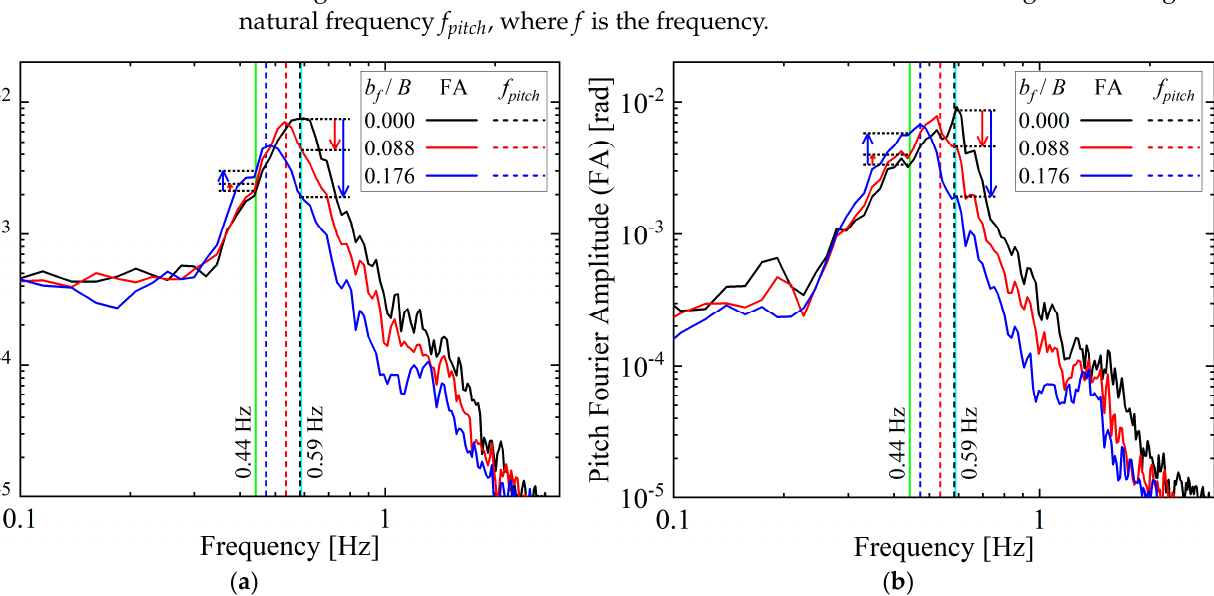
Figure 21. Fourier amplitude (FA) of the pitch for the irregular waves: ( a ) f s = 0.59 Hz; ( b ) f s = 0.44 Hz.